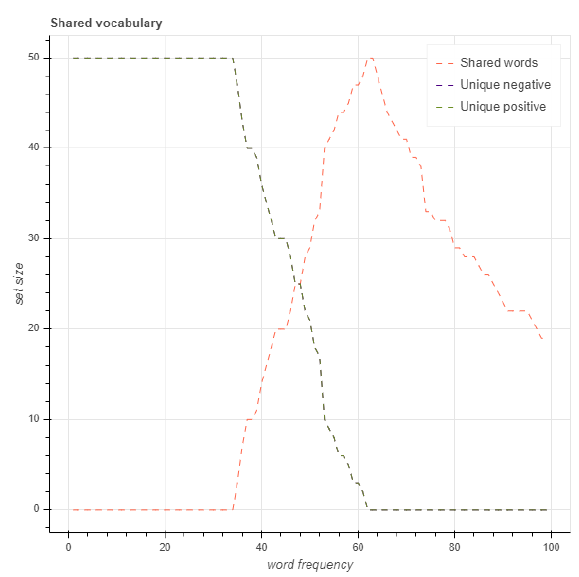
Figure 1. Shared word set vs unique word set size. Note unique positive and negative plots